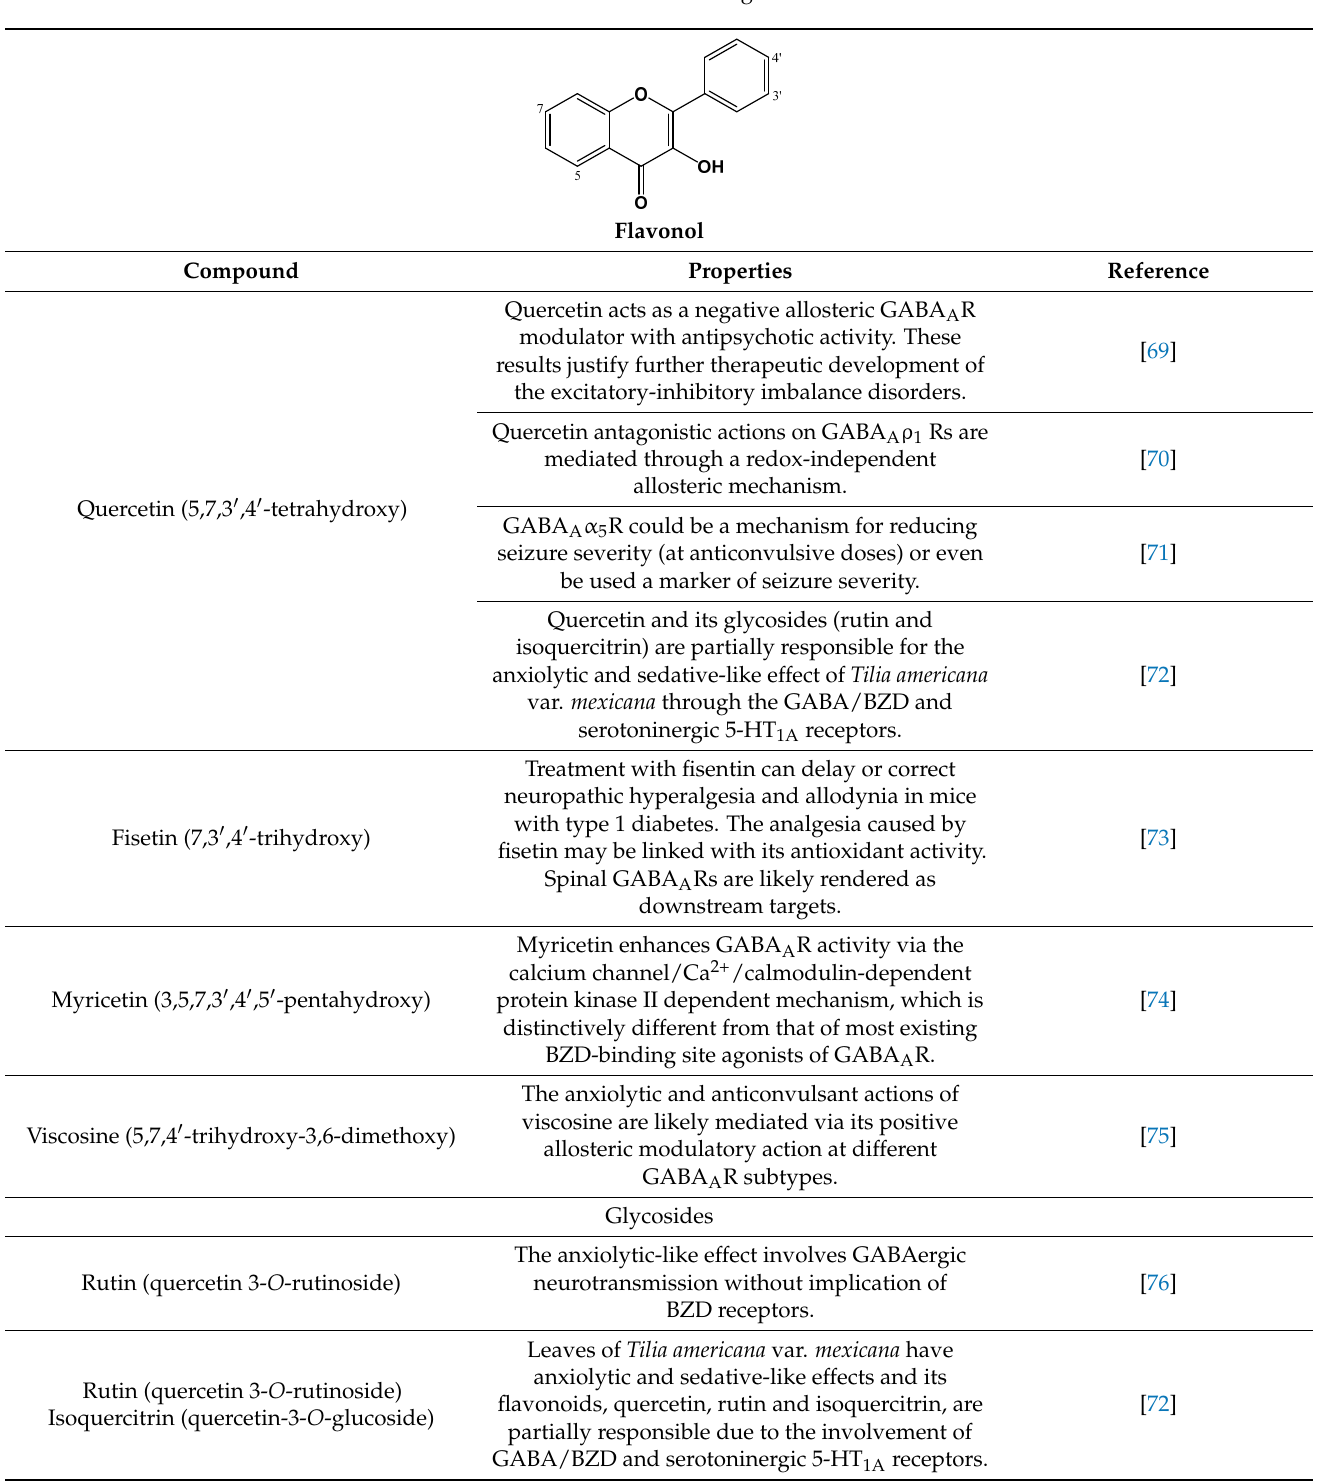
Table 1. Flavonols with relevant GABAergic effects.